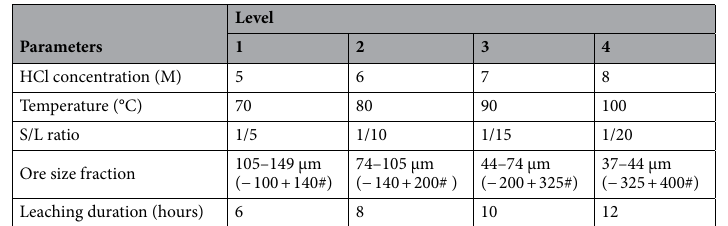
Table 3. Experimental variable and its level of variation.